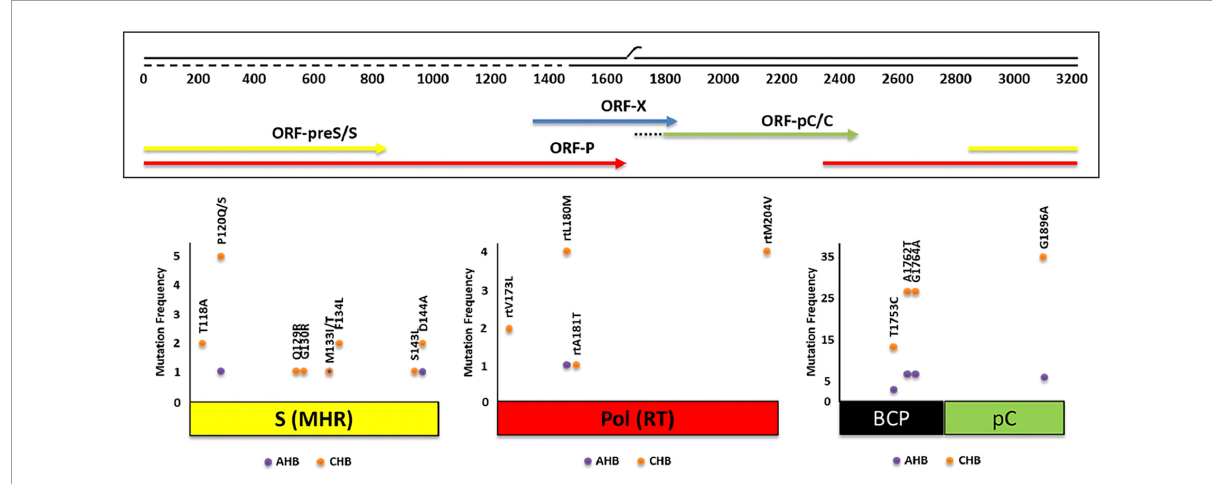
FIGURE4 Absolute frequency of mutations obtained for three genomic regions of hepatitis B virus (HBV) [open reading frame (ORF)-S, ORF-P, ORF-pC/C] of 217 patients with acute (AHB) and chronic (CHB) infection. Some of the mutations were found simultaneously.